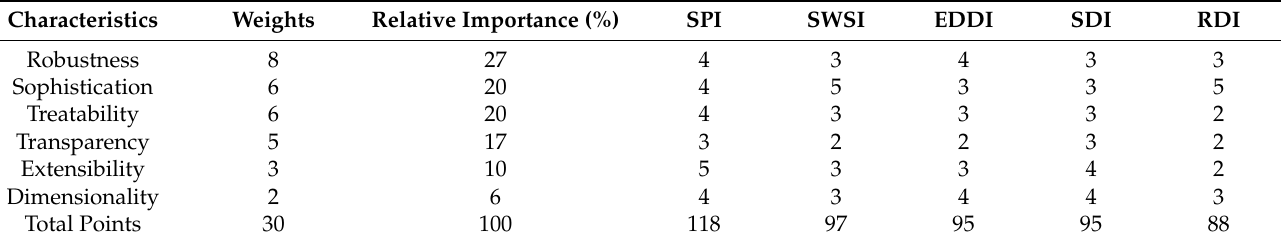
Table 15. Qualitative evaluation of drought